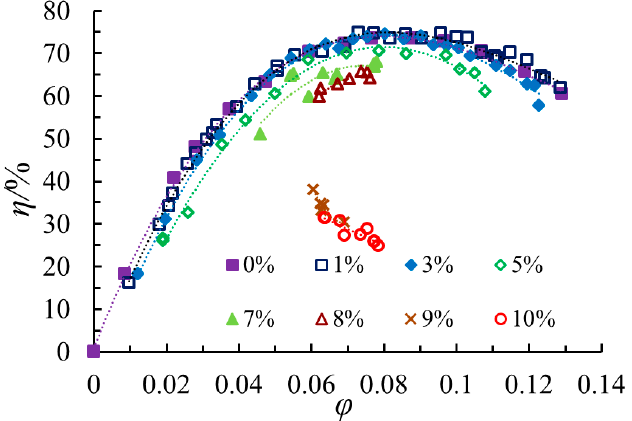
Figure 7. Head coefficient versus flow coefficient (extracted from Si et al. [24]).